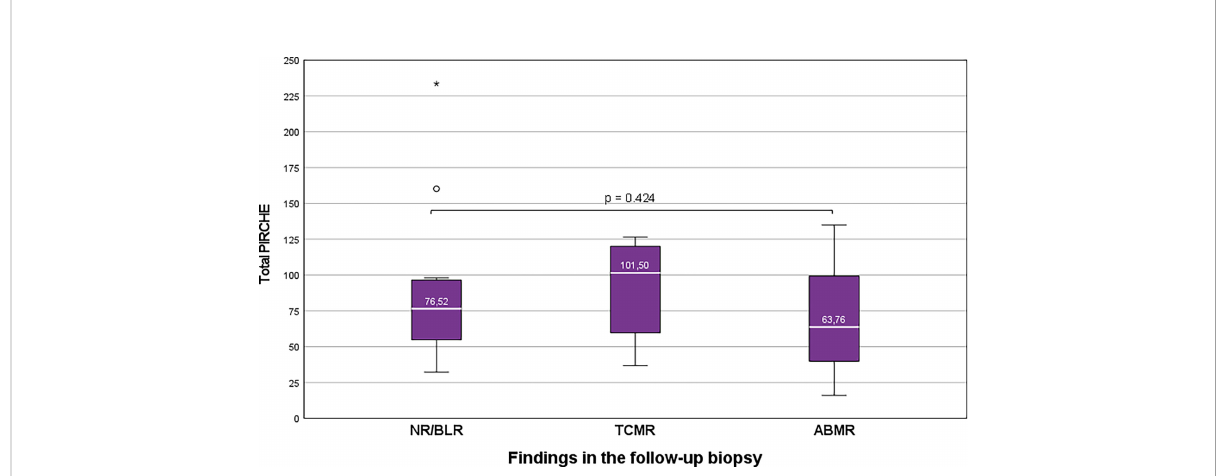
FIGURE 4 Higher total PIRCHE-II scores among KTRs who show ongoing TCMR than KTRs with NR/BLR/ABMR. Boxplots show median, interquartile range (IQR), and 95 th percentile The asterisk (*) marks the maximum